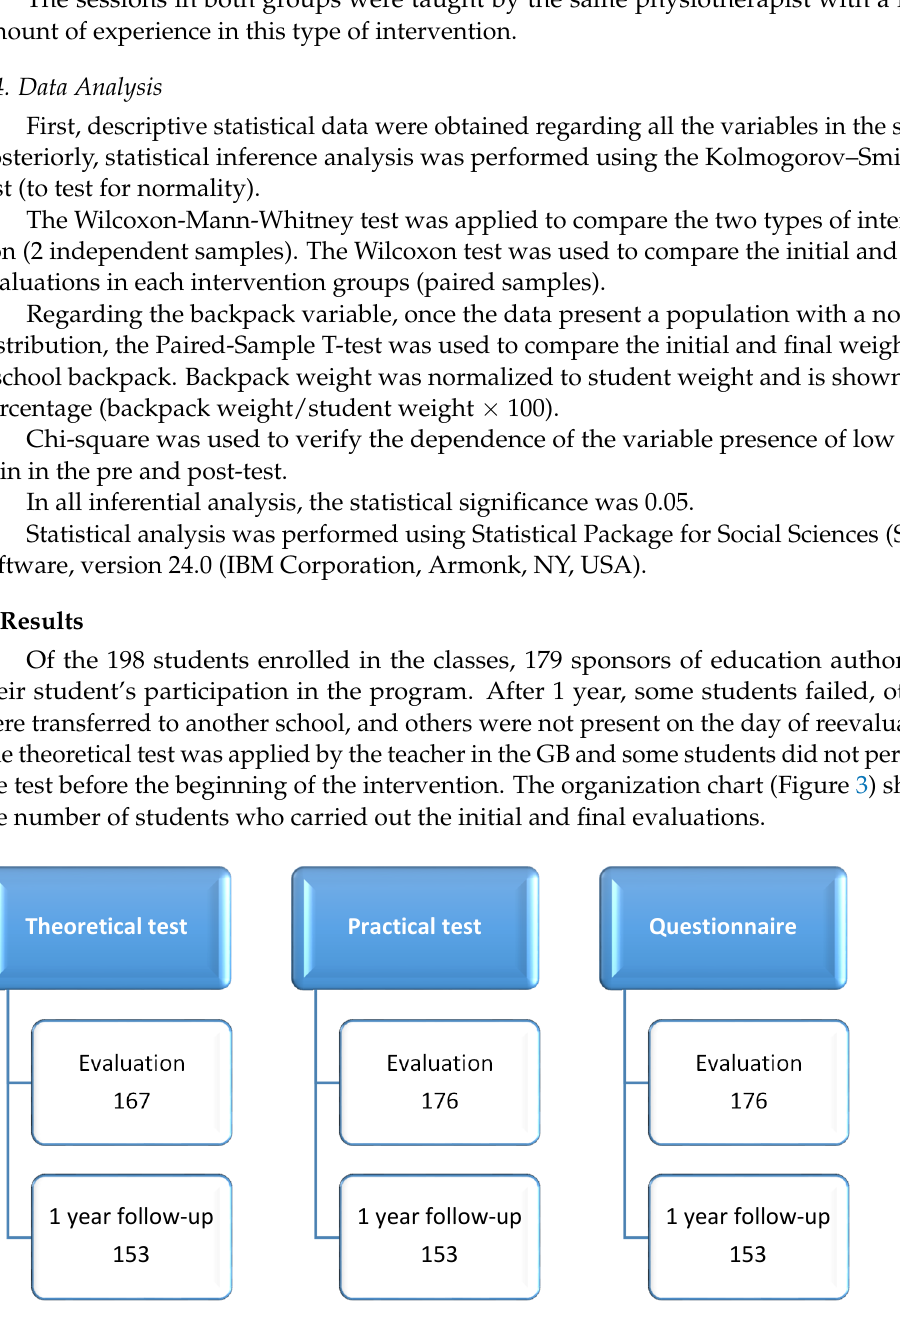
Figure 3. Number of students who performed the evaluations.